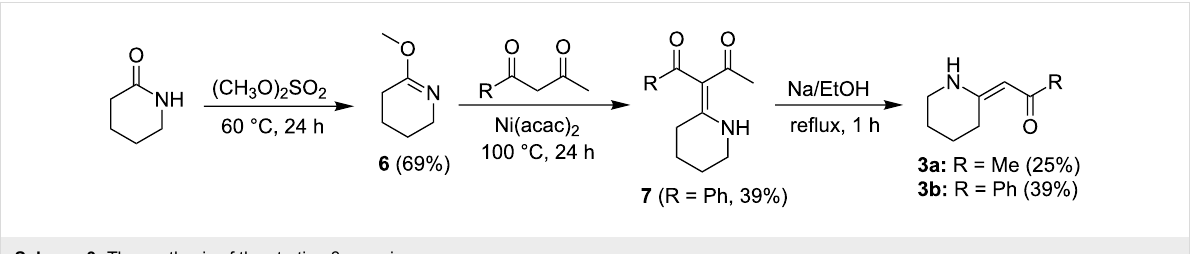
Scheme 3: The synthesis of the starting β -enaminones.